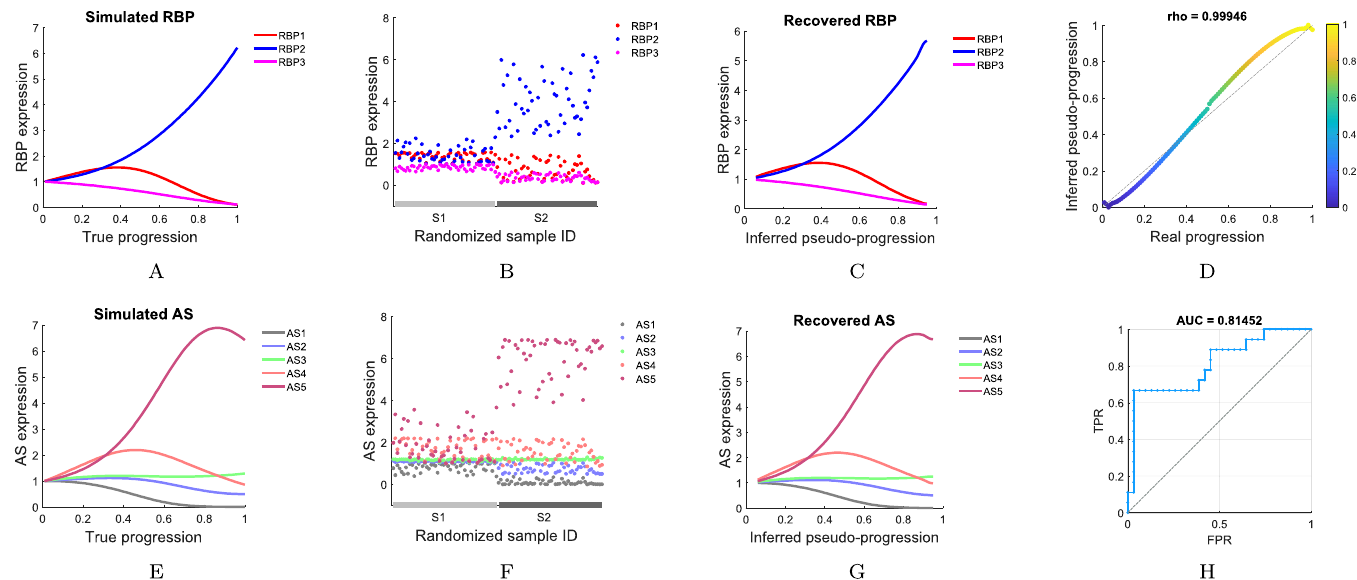
Fig 2. Illustrating the function of our proposed model using a synthetic dataset. A set of expression data for 3 RNA-binding proteins (RBPs) and 5 alternative splicing (AS) events in 100 cancer specimens was simulated. (A) and (E) Original RNA-binding protein (alternative splicing event) expression data. (B) and (F) Simulated cross- sectional RNA-binding protein (alternative splicing event) expression data. The sample IDs of the synthetic data were randomized and the EM transition process information was retained. (C) and (G) Recovered RNA-binding protein (alternative splicing event) expression dynamics according to inferred pseudotime progression trajectory. (D) Comparison of the inferred pseudotime progression with the true progression in the synthetic dataset, evaluated using Spearman’s rank correlation coefficient (rho). (H) Accuracy of the dynamical systems inference evaluated using the AUC of ROC.